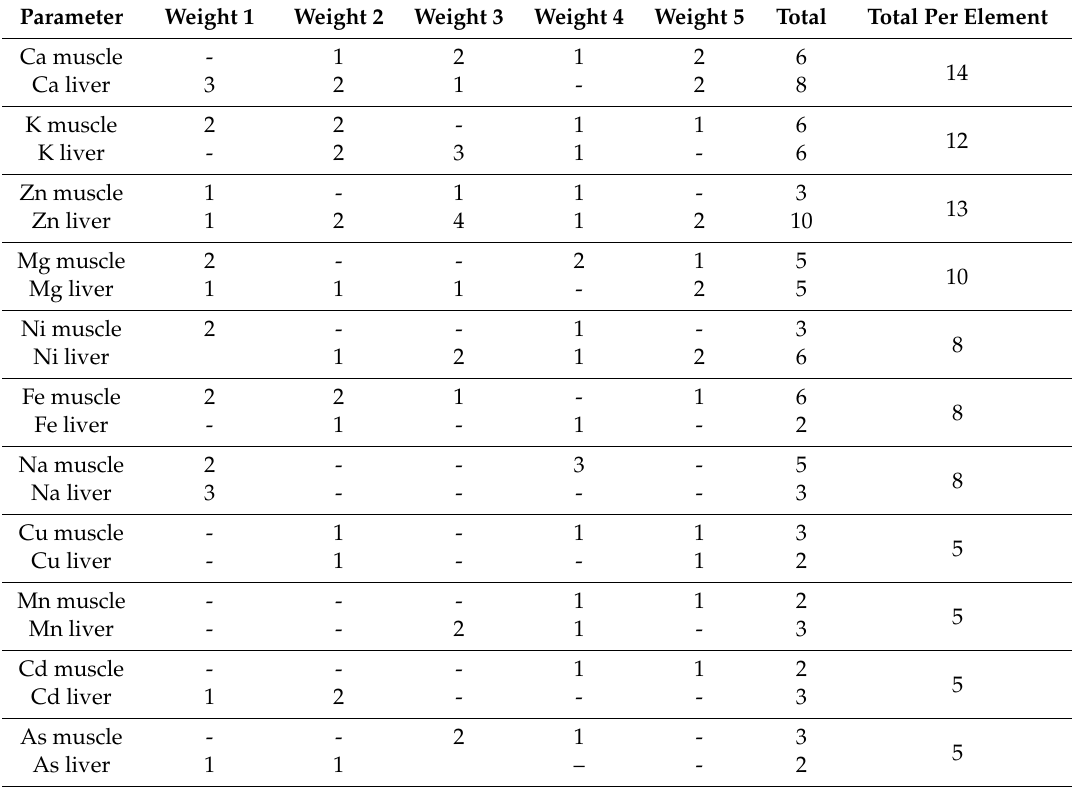
Table 1. Feature importance of elements in all Random Forest (RF) models from current